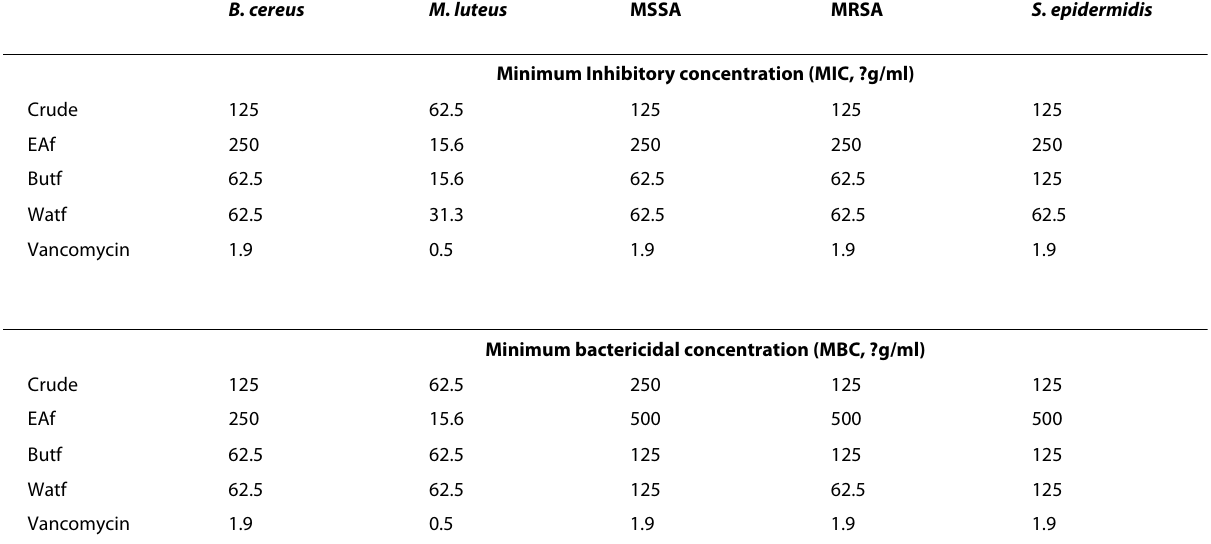
Results are mean from three sets of experiments, each set in triplicate.